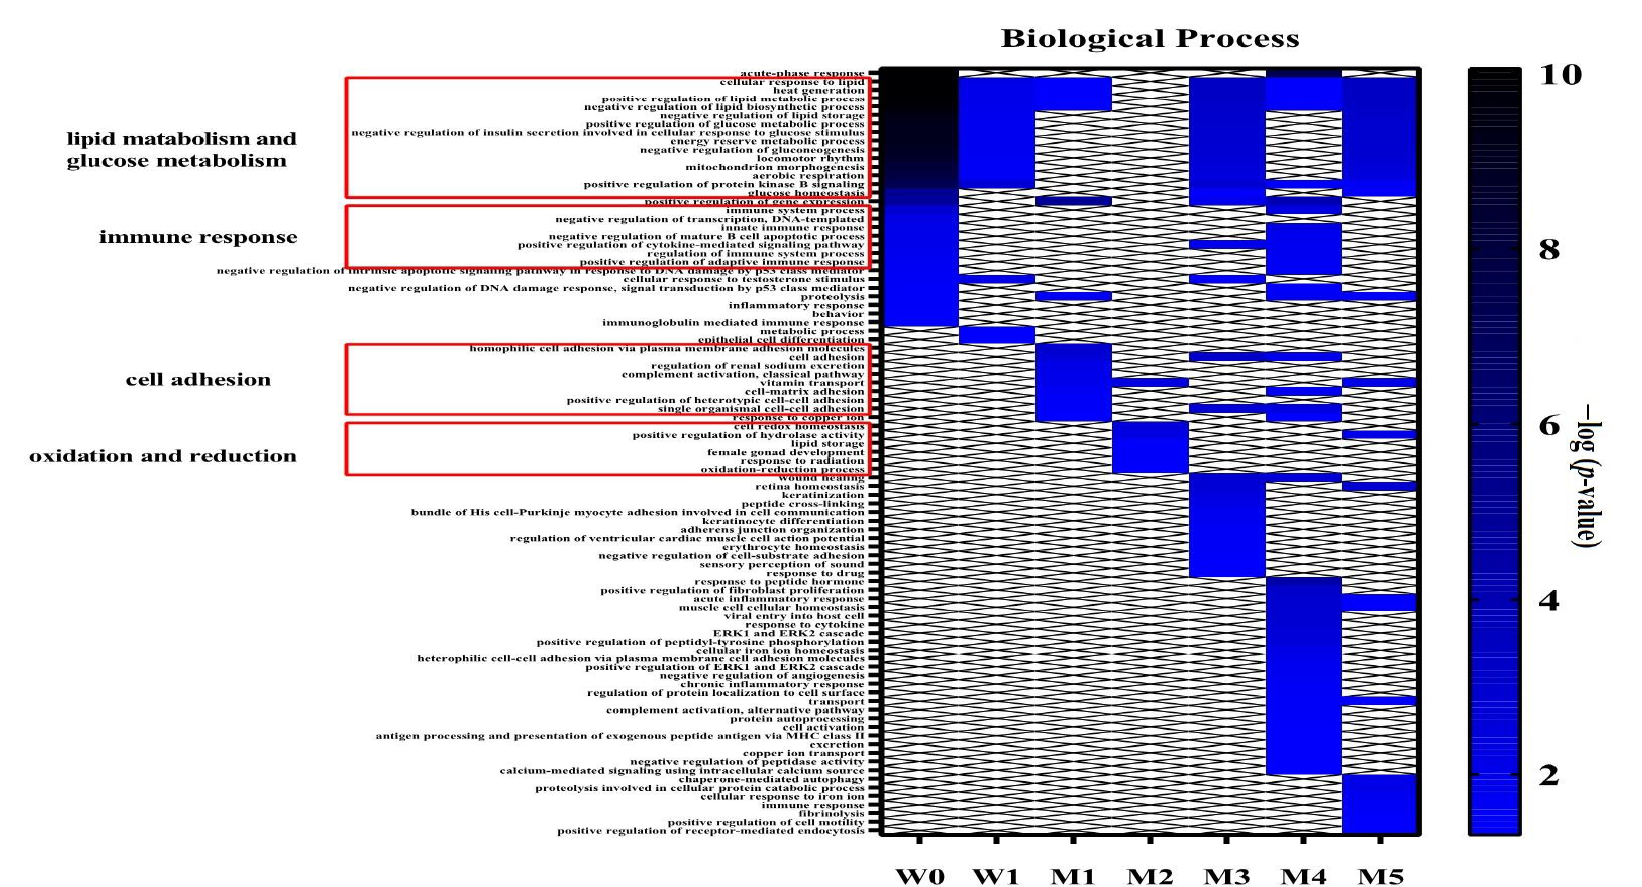
Figure 5. Functional annotation of differential proteins at different time points between the experimental and control groups (p < 0.05). When the experimental group is compared to the control group, there is a large difference in W0, demonstrating that the urinary proteome reflects even slight difference between the groups. In the subsequent control results at each time point, the degree of overlap in the differential proteins is small, but they are mostly related to lipids and cardiovascular diseases. The enriched biological processes also correspond to the progression of atherosclerosis, indicating that the urinary proteome is useful to monitor the disease process. However, as mentioned before, this type of comparison does not take the influence of diet and other factors into account.3.3. Chemical Modifications of Proteins.